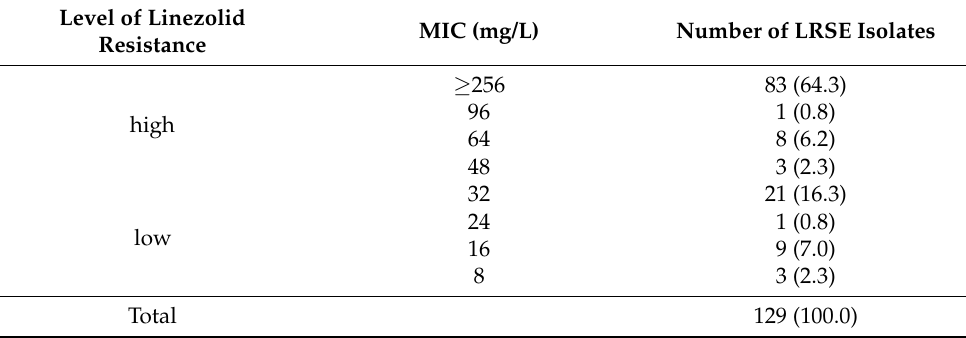
Table 2. Minimal inhibitory concentration (MIC) of linezolid-resistant Staphylococcus epidermidis (LRSE) isolates. Percentages are given in